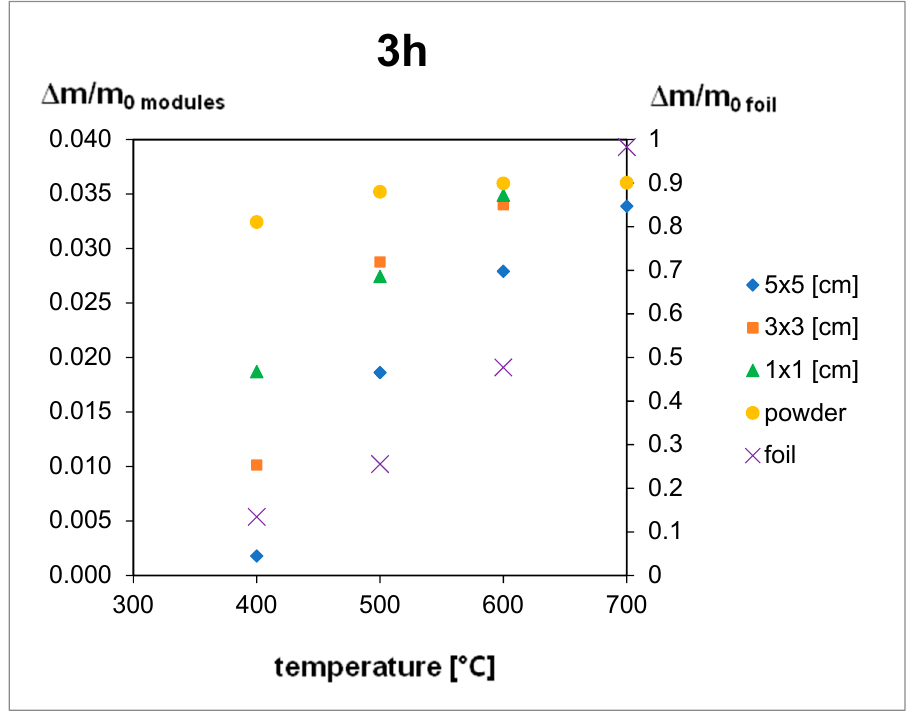
Figure 6. Results of the thermal treatment of module pieces and EVA foil for 3 h.